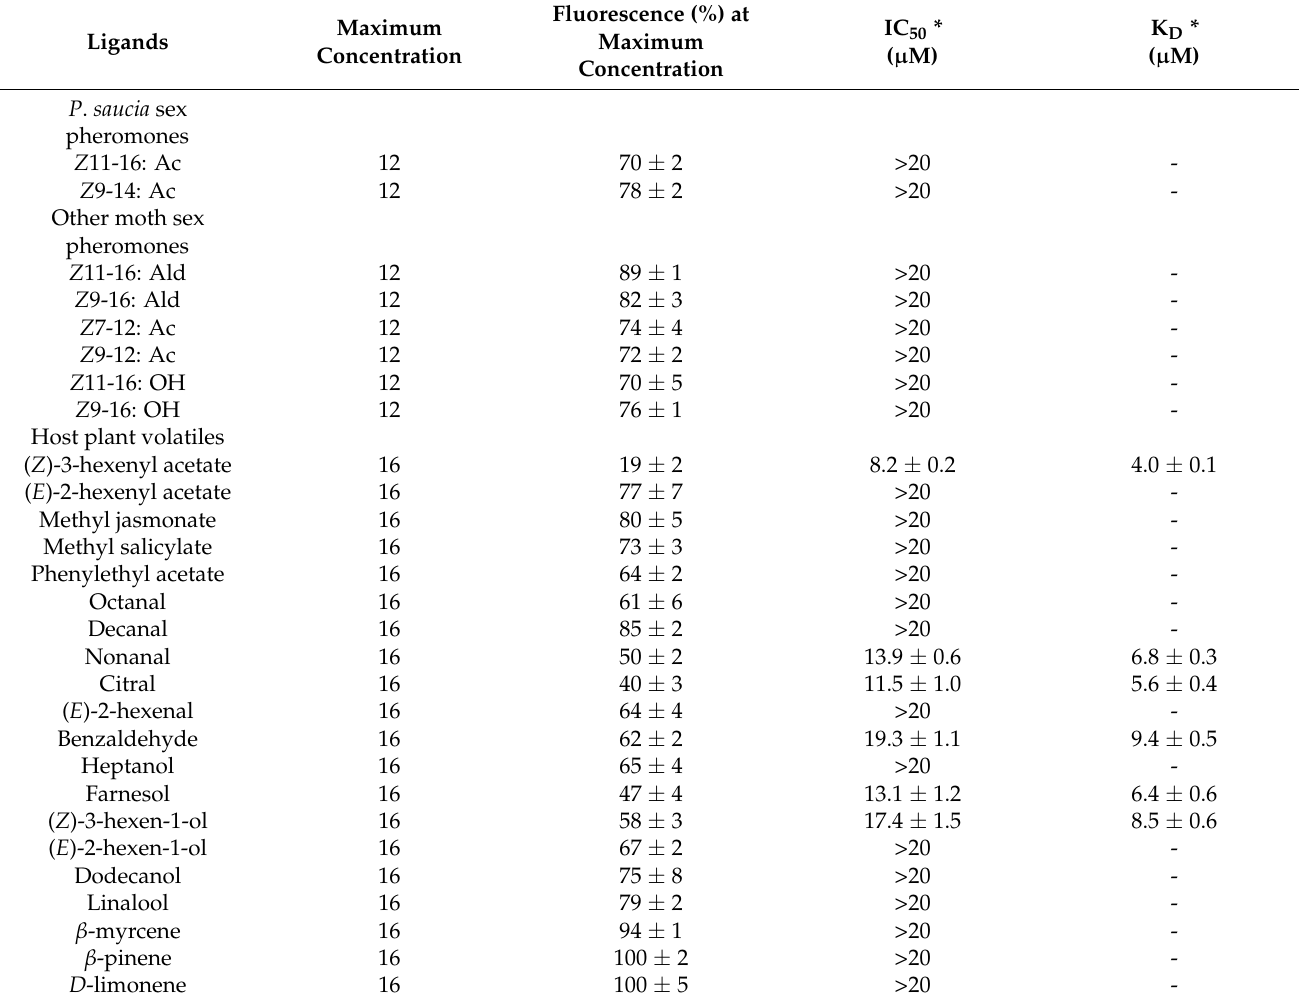
Figure 7. Competitive-binding assays of selected ligands to the recombinant protein PsauGOBP1. ( A ) Moth sex pheromones; ( B ) selected host plant volatiles. In each assay, a mixture of the protein and 1-NPN in Tris, both at 2 mM, was titrated with the competing ligand to final concentrations of 12 µ M (sex pheromone components) or 16 µ M (host plant volatiles). Affinities of 8 sex pheromone components and 26 host plant volatiles were tested, and the data for all of the tested ligands are reported in Table 1. Table 1. Binding capability of recombinant PsauGOBP1 to tested